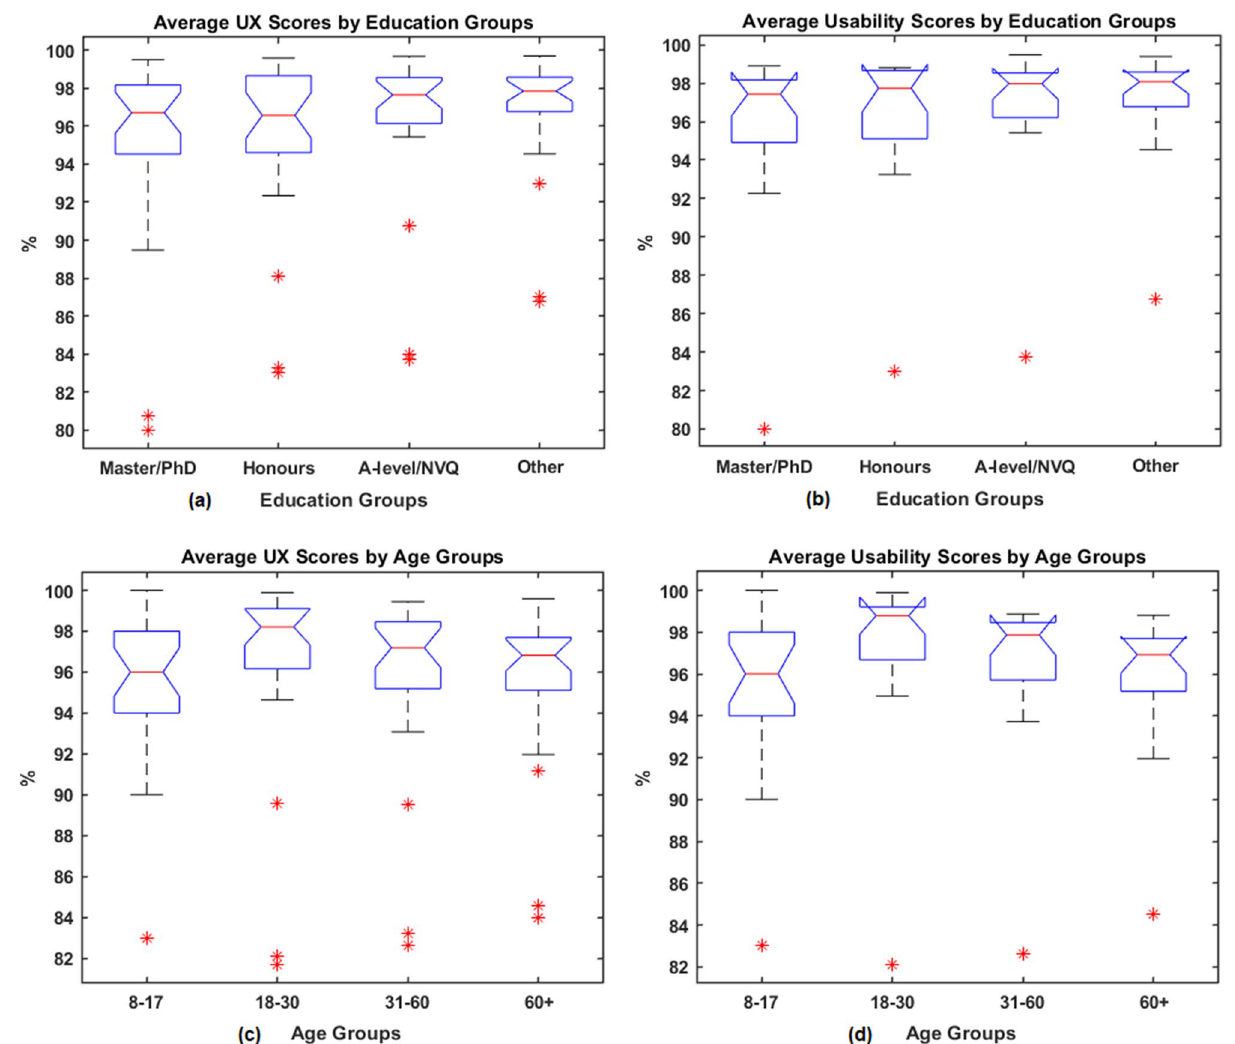
Figure 5. Boxplot for average of: (a) UX scores by education groups; (b) Usability scores by education groups; (c) UX scores by age groups and (d) Usability scores by age groups.